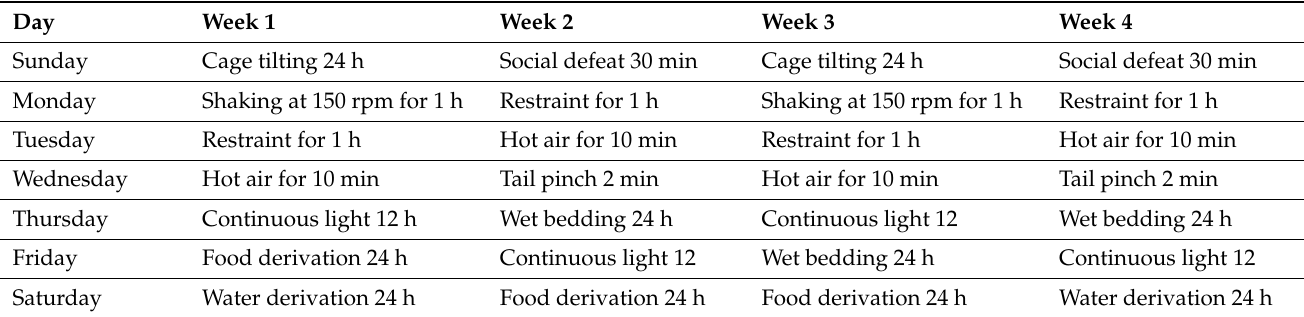
Figure 1. Schematic representation of the experimental design. Table 1. Schedule and durations of variable mild stressors used in the study.